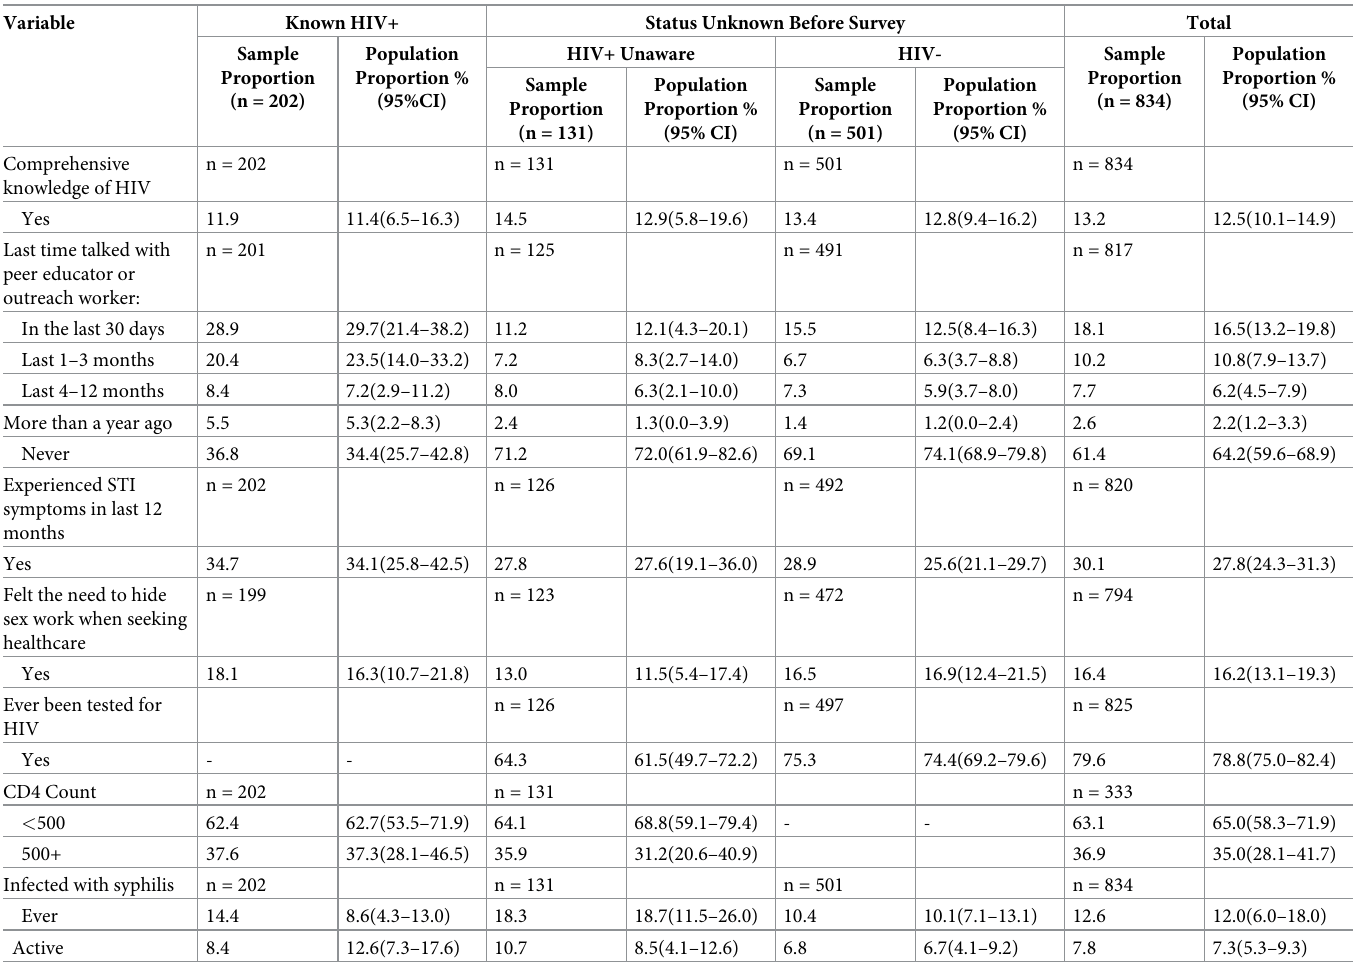
Table 3. Knowledge and healthcare service utilization characteristics among FSW in Juba, South Sudan